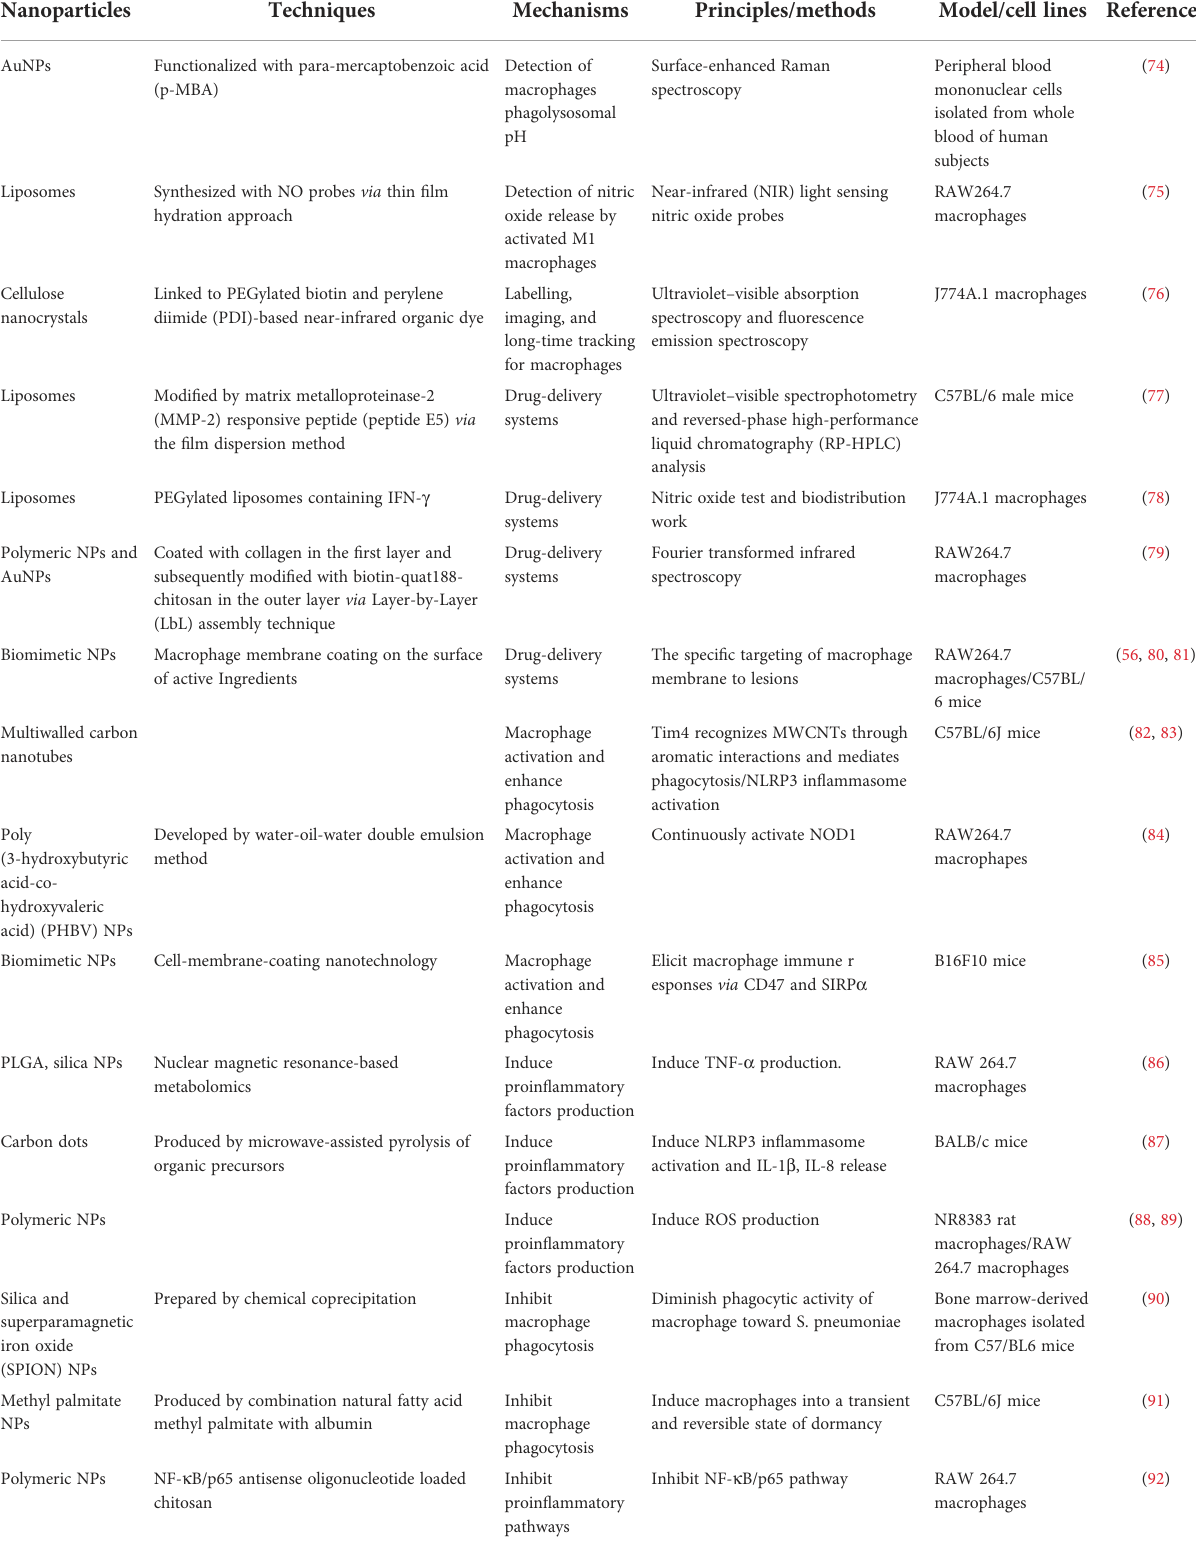
TABLE 1 The classi fi cation and mechanism of nanoparticles targeting